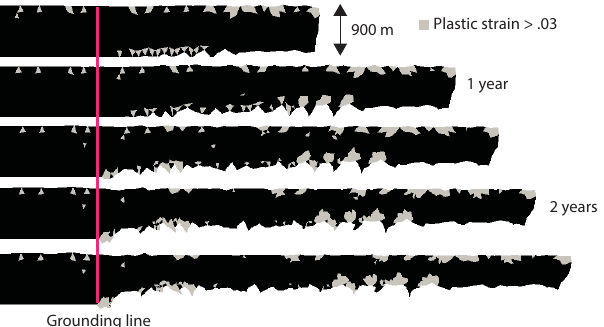
Figure 7. Plastic strain over 2.5 years of model time. Ice fails in tension at the surface near the terminus with regularity at the grounding line where hydrostatic stress is applied (in pink). Ice forms boudin-like features after accommodating a large amount of strain.